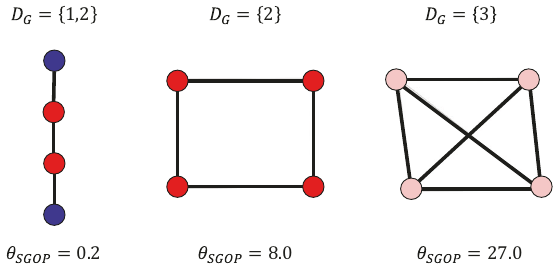
Fig. 2 Theoretical validation of the SGOP formalism. The coloring of the nodes corresponds to their respective degree value. The degree set used to calculate the SGOP is shown above each graph, while the calculated SGOP value for the graph is shown below it. Here, the degree value is simply taken as the number of edges into each node.